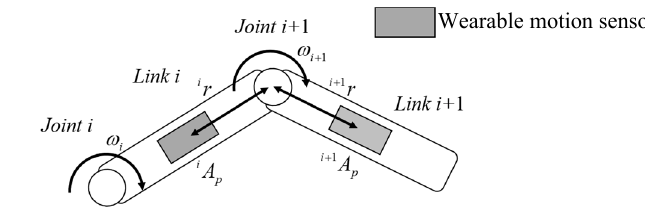
Figure 2. Two-link model for estimation of posture in local